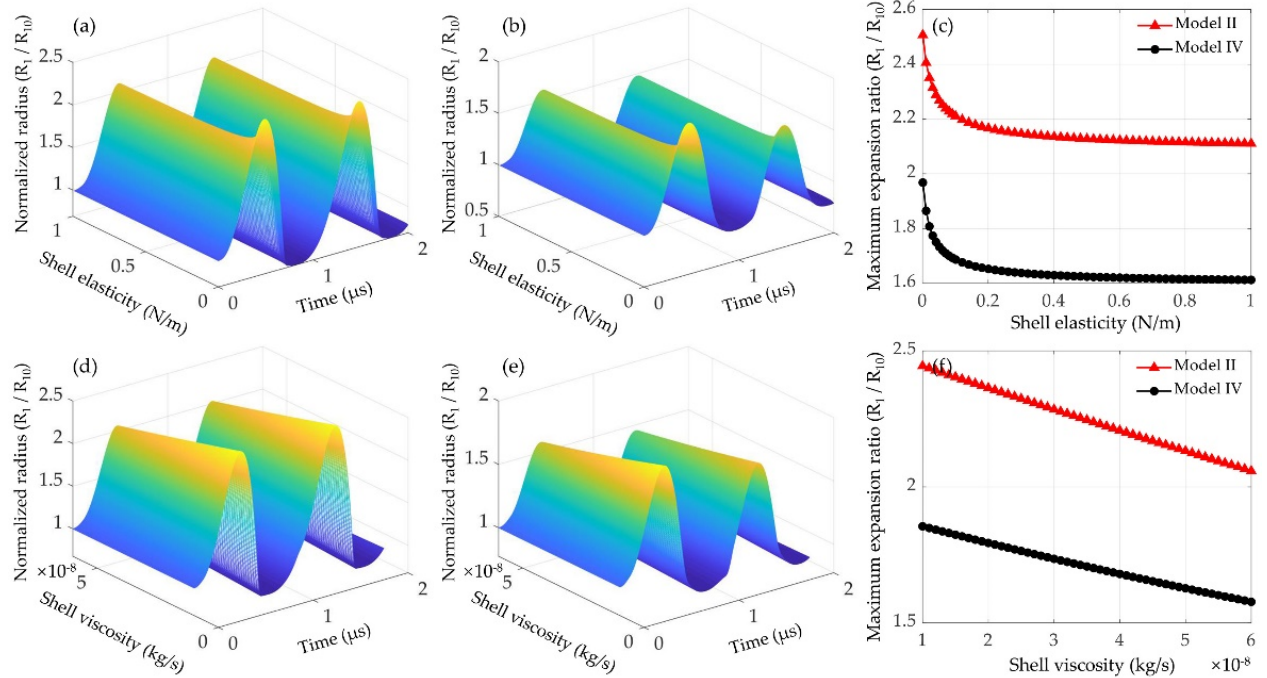
Figure 5. Normalized radii of a 1 µ m lipid-coated bubble as a function of time ( a ) without (model II) and ( b ) with (model IV) considering the inter-bubble interactions with a large lipid-coated bubble ( R 20 = 5 µ m), and ( c ) the corresponding maximum expansion ratios at different shell elasticities, while ( d – f ) represent those at different shell viscosities. The amplitude of applied ultrasound is 400 kPa, and the inter-bubble distance is 20 µ m.